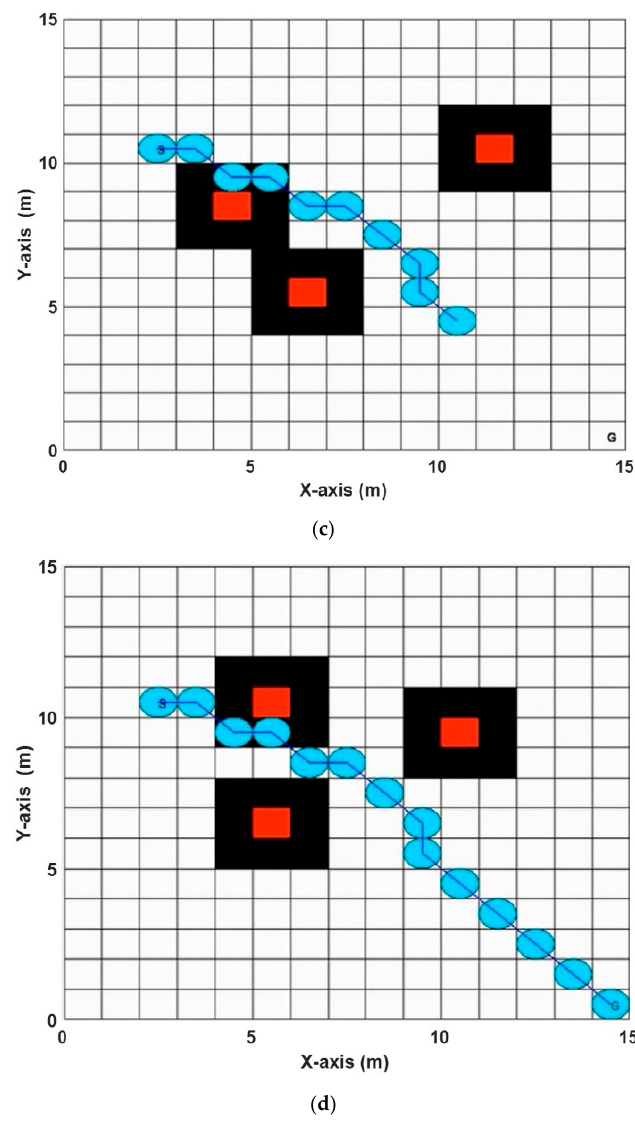
Figure 14. The best path achieved within the ABACO grid-based dynamic environment 1, ( a ) the mobile robot starts from its starting position, ( b ) the mobile robot is moving toward its goal position, ( c )